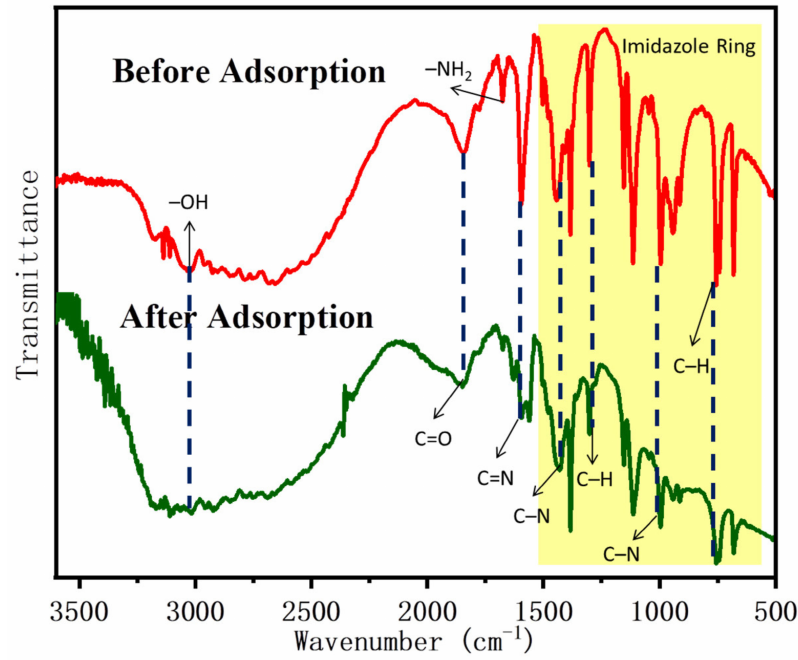
Figure 16. FTIR spectra of EDTA–CS@ZIF-8 composites before and after adsorption of